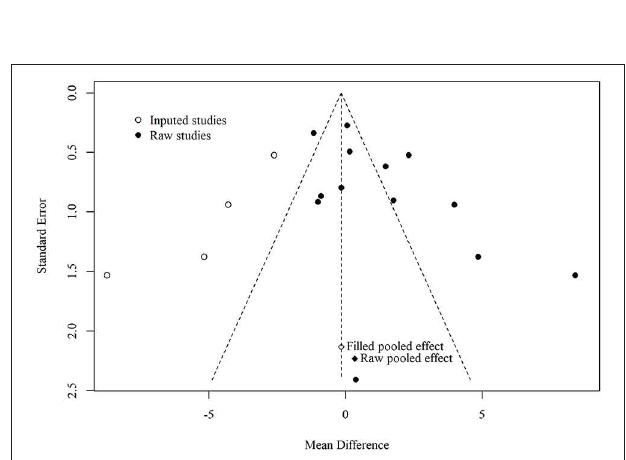
FIGURE 5 | The funnel plot for general cognitive function of acupuncture vs. drug therapy in the medium.